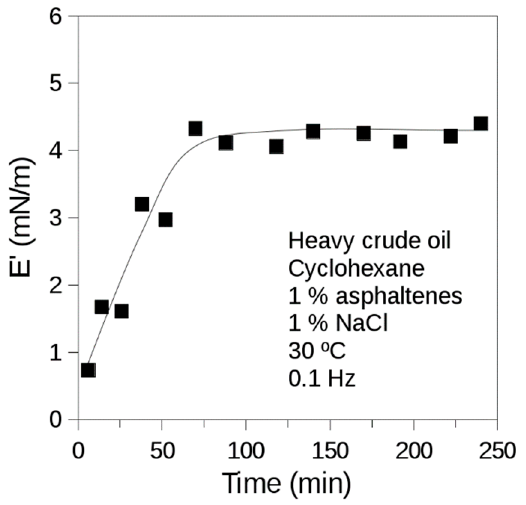
Figure 8. Dynamic elastic modulus of a brine (1% NaCl)-heavy crude oil diluted in cyclohexane (1% asphaltenes). Heavy Venezuelan crude oil of 8° API with high asphaltene content (17 wt%) diluted in cyclohexane. T = 30 °C. Measurement made with the oscillating spinning drop equipment. Frequency 0.1 s − 1 .